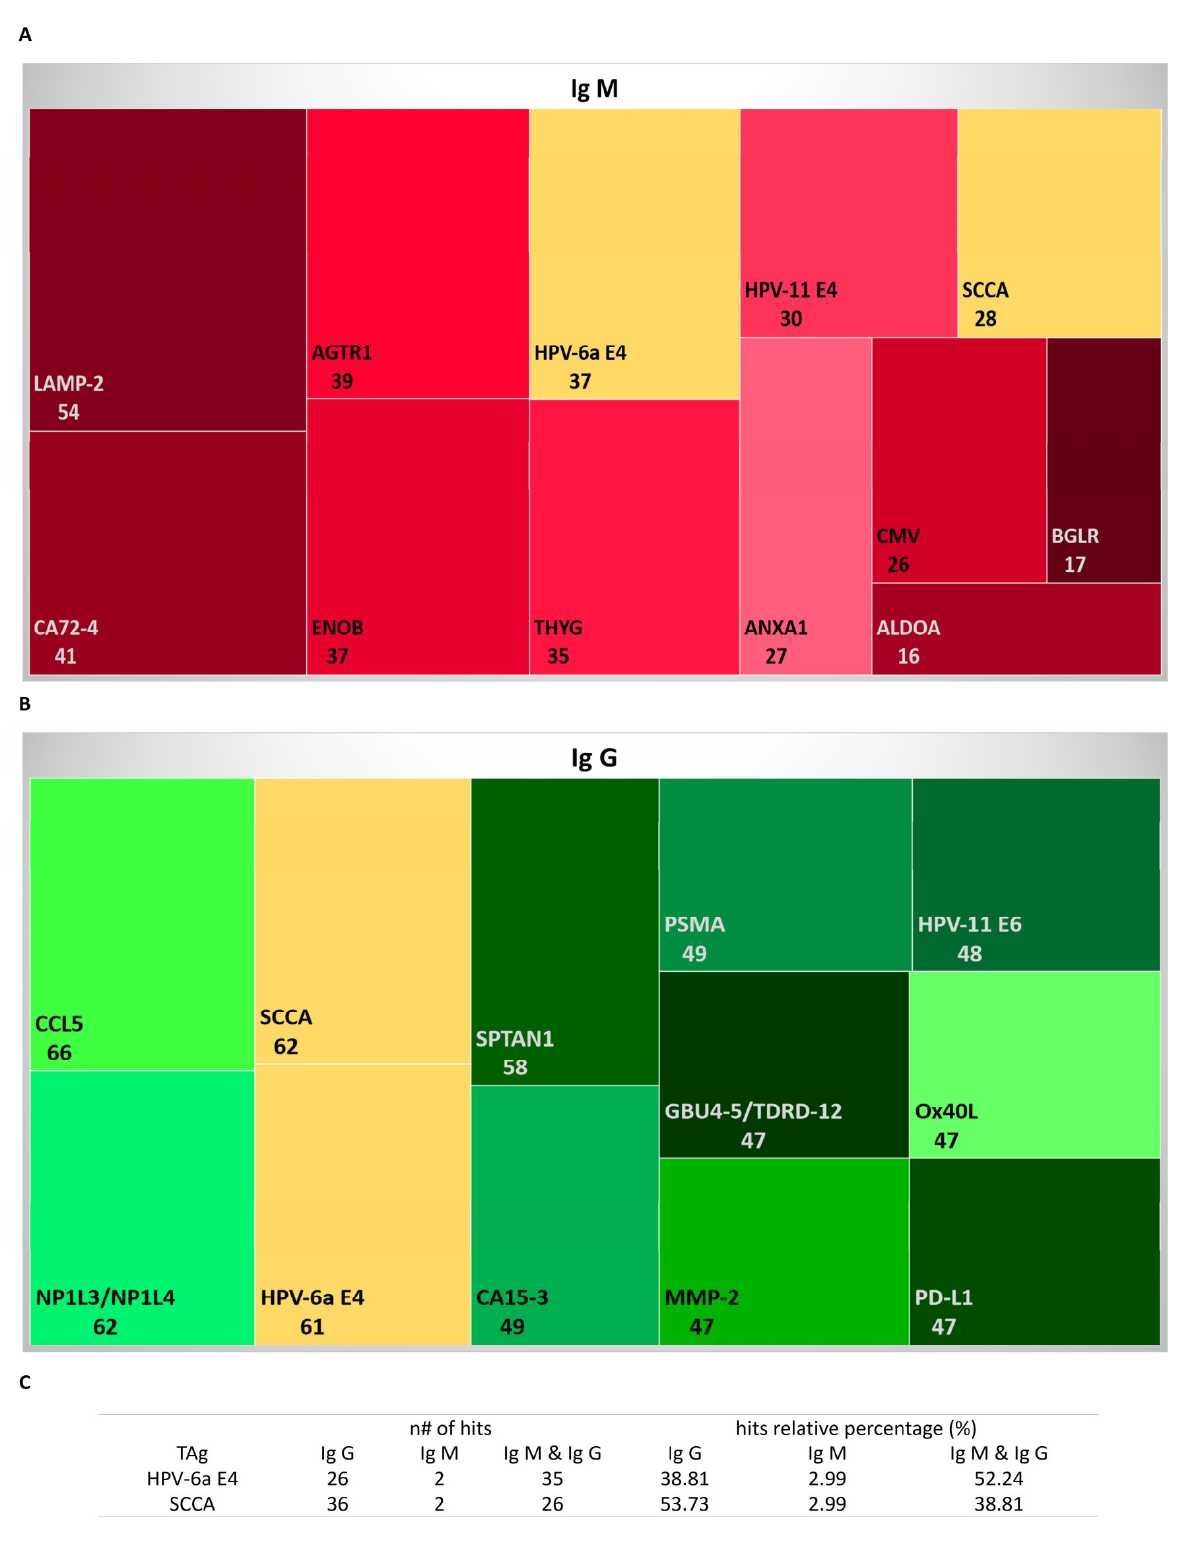
Figure 2. Quantitative summary of top 10 tumoral antigens (TAs) detected in this study: ( A ) TAs detected by IgG autoantibodies (aAbs) in the studied cohort; ( B ) TAs detected by IgM aAbs in the studied cohort; ( C ) number ( n #) and percentage (%) of samples for each detected aAb with respect to the total studied cohort.